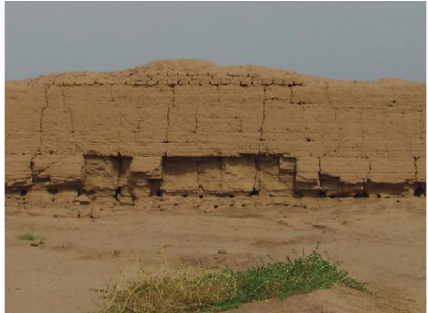
Figure 1: Rammed earth site of Gaochang ruin.